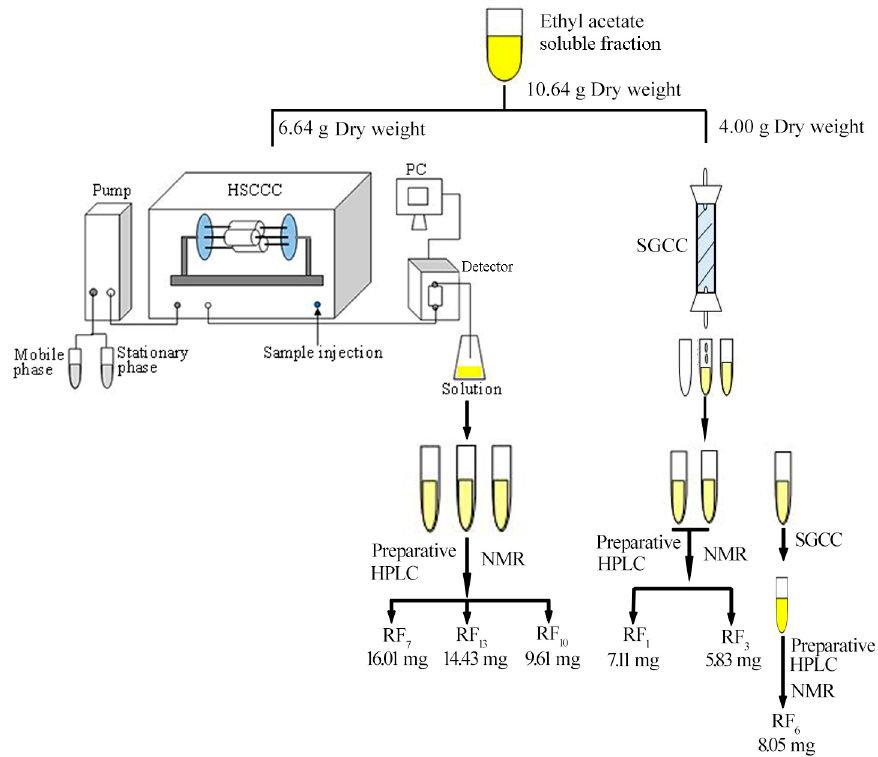
Figure 5. Isolation flow schematic diagram of compounds from ethyl acetate fraction. RF1, ergosterol; RF3, ergosta-7,22-dien-3 β -yl pentadecanoate; RF6, 3,4-dihydroxy benzaldehyde; RF7, inoscavin A; RF10, baicalein; RF13, 24-ethylcholesta-5,22-dien-3 β -ol. HSCCC: high-speed countercurrent chromatography; SGCC: silica gel column chromatography.